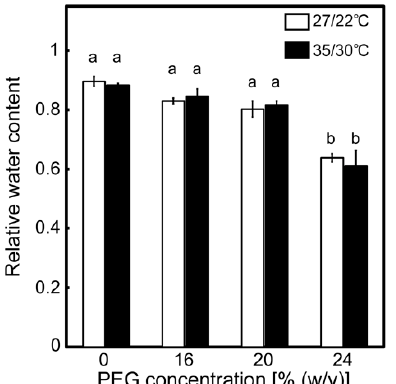
Figure 1. Relative water content of leaves after the drought stress treatment under two di ff erent temperature conditions in rice. Approximately 60 days after germination, hydroponically grown plants were drought-stressed using culture solutions containing PEG at 0, 16, 20, and 24% ( w / v ) for two days under an irradiance of 450 µ mol photon m − 2 s − 1 and day / night temperature regimes of 27 / 22 ◦ C and 35 / 30 ◦ C. On the day following the stress treatment, the uppermost fully expanded leaves were collected for analysis. White and black bars denote plants stressed under the 27 / 22 ◦ C and 35 / 30 ◦ C conditions, respectively. Data are presented as means ± SE ( n = 3 to 5). Statistical analysis was carried out by ANOVA, followed by Turkey–Kramer’s test. Columns with the same letter were not significantly di ff erent ( p < 0.05).